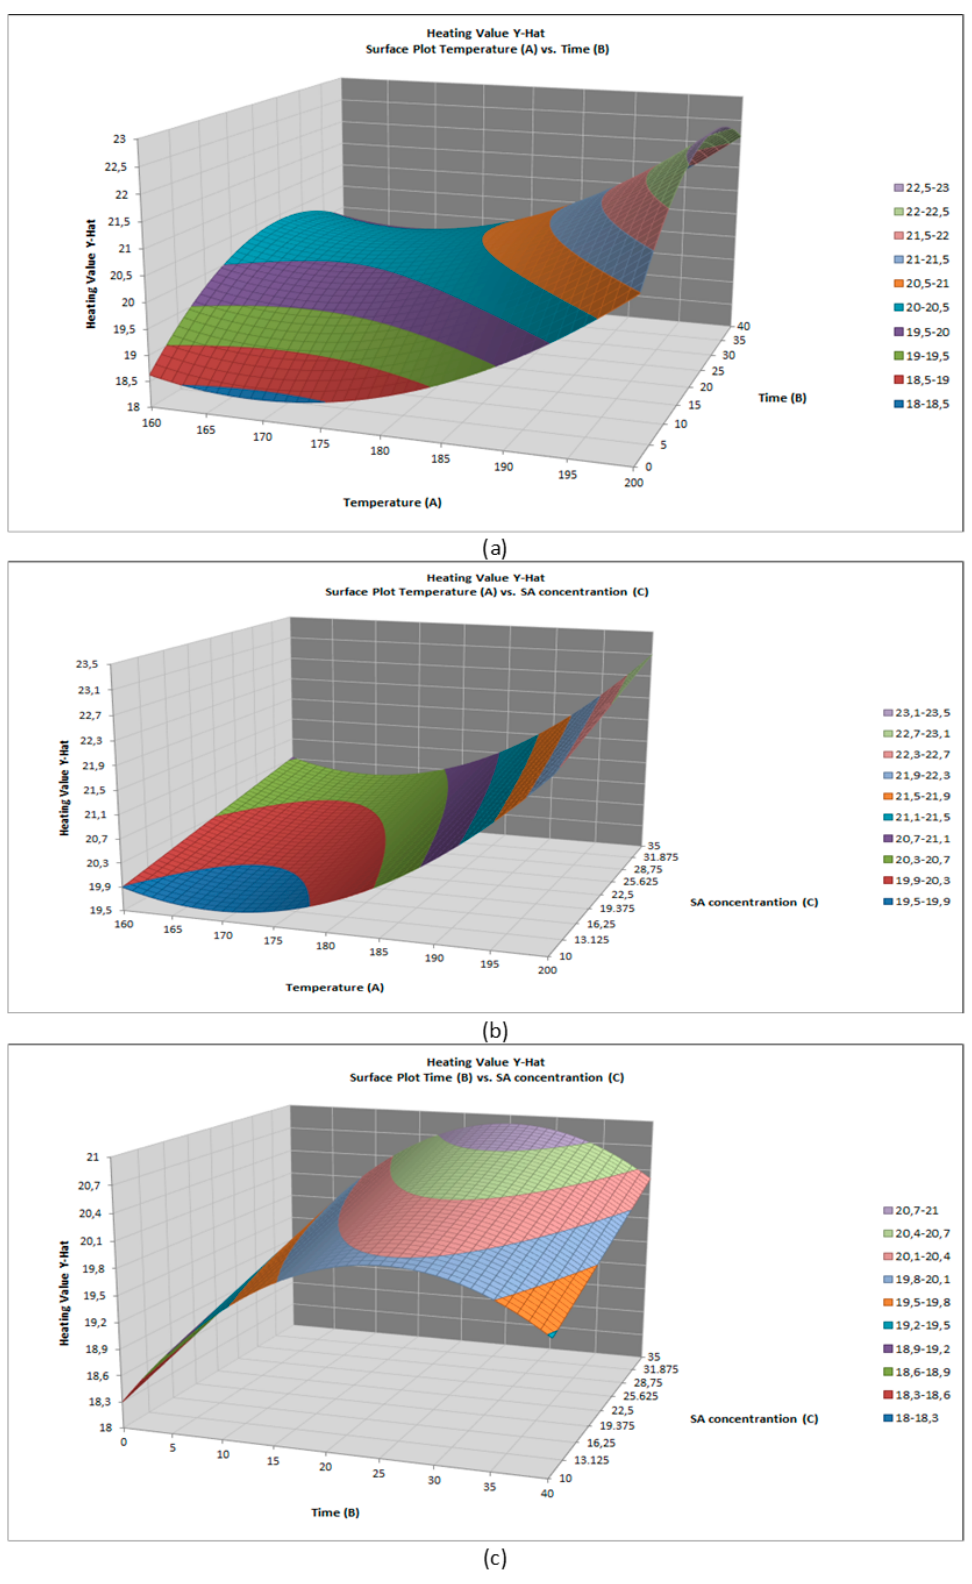
Figure 5. HHV vs. temperature–time ( a ), temperature–SA concentration ( b ) and SA concentration–time ( c ).